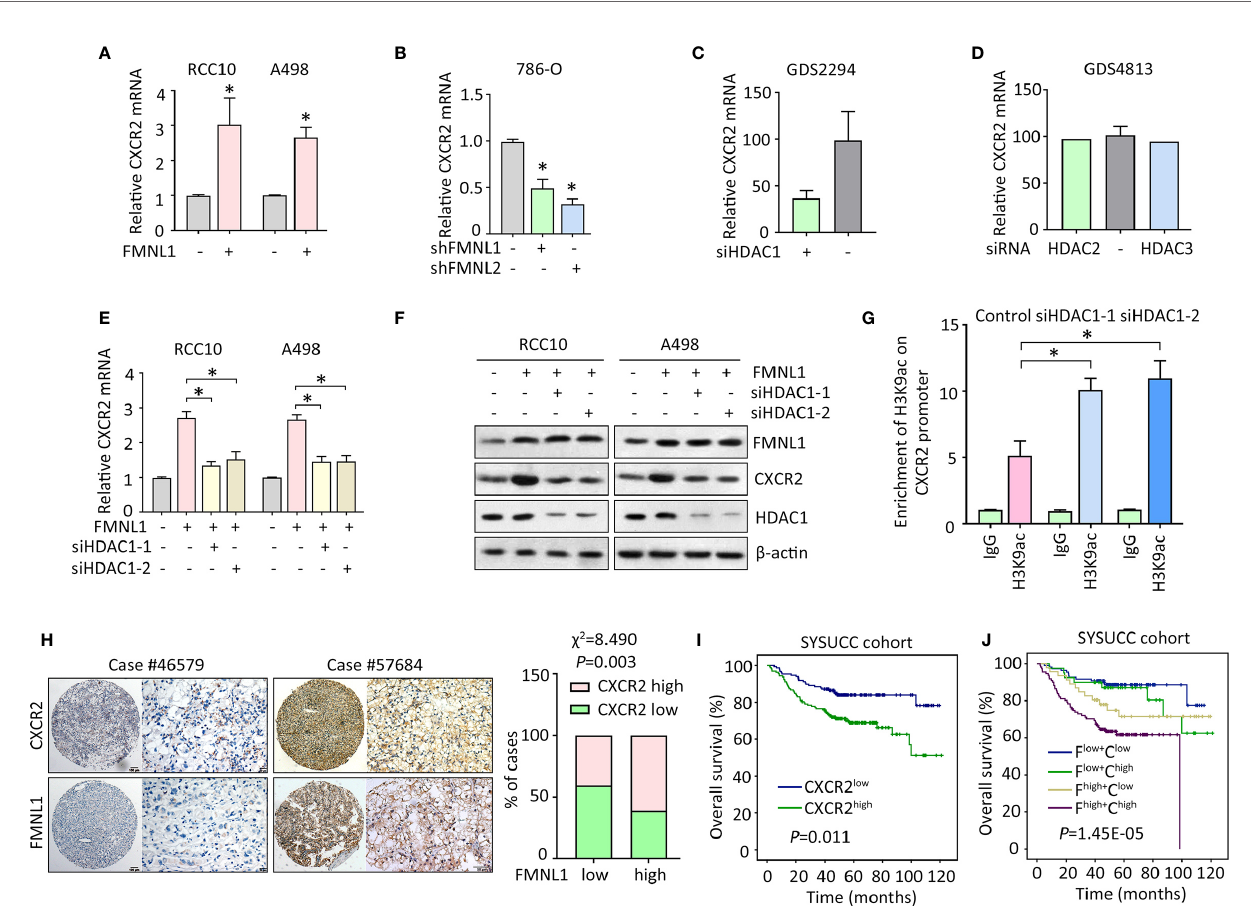
FIGURE 5 | FMNL1 upregulates CXCR2 via HDAC1 in ccRCC cells. (A , B) The expression of CXCR2 mRNA in stable cells with FMNL1 overexpression (A) and knockdown (B) was determined by qRT-PCR. * P < 0.05. (C , D) CXCR2 mRNA expression was determined in cells treated with siRNA for HDAC1, HDAC2 or HDAC3 in human cancer cells. Data were from GEO datasets (no. GDS2294 and GDS4813). (E , F) Cells with FMNL1 overexpression were transfected with HDAC1 siRNAs for 36 h. CXCR2 mRNA (E) and protein (F) expressions were determined by qRT-PCR and western blot. * P < 0.05. (G) The histone H3 acetylation at